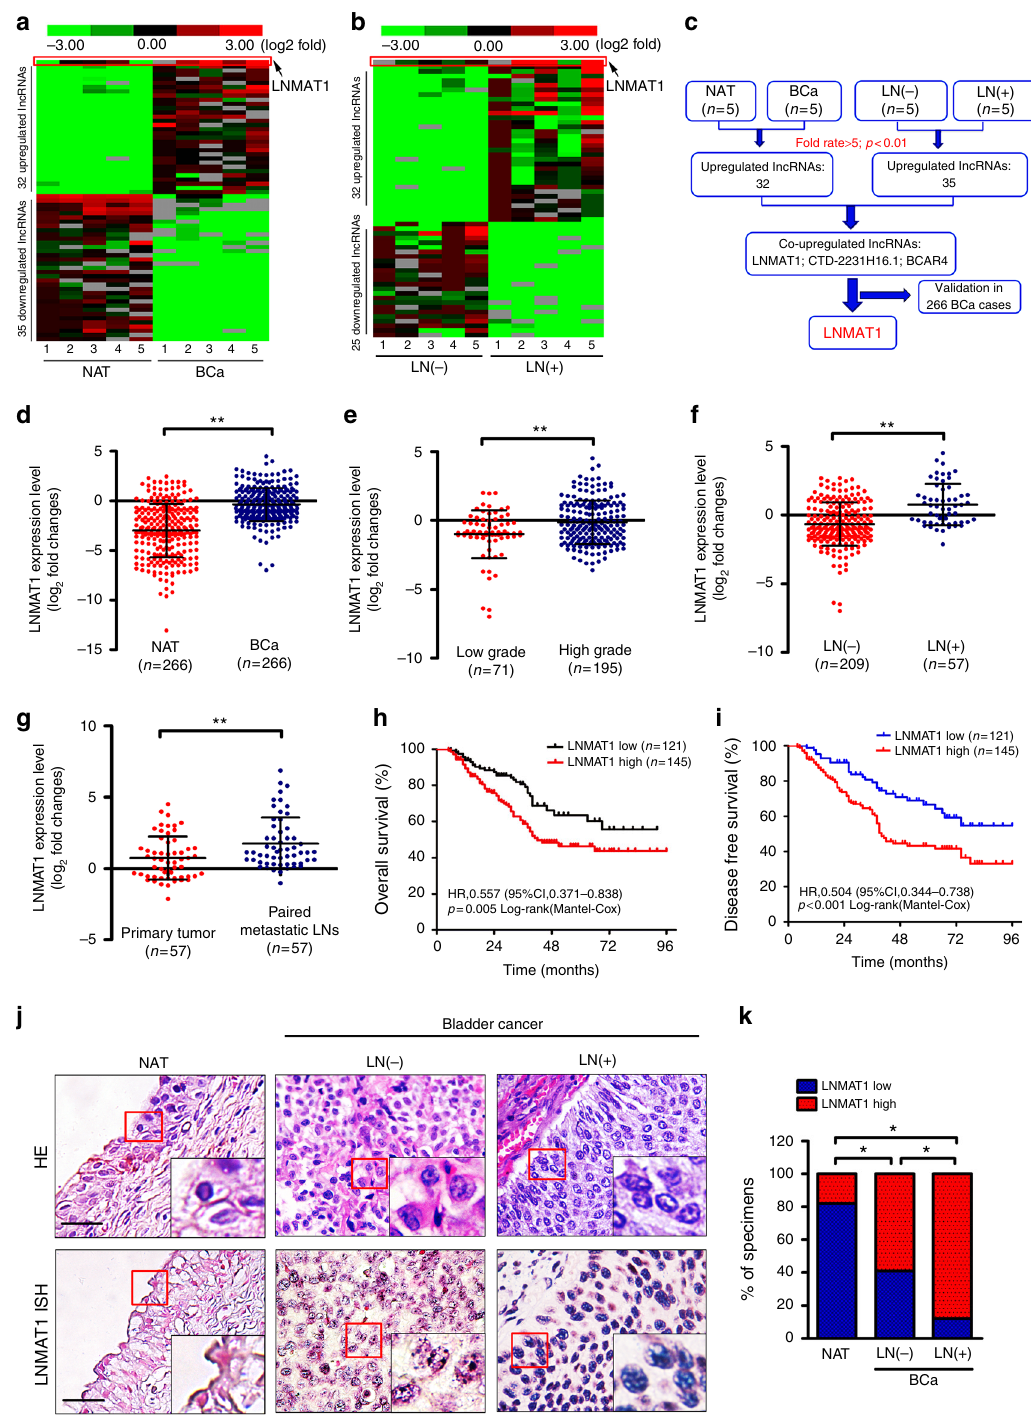
The UM-UC-3/luc and 5637/luc bladder cancer cell lines stably overexpressing LNMAT1 or a short hairpin RNA (shRNA) targeting LNMAT1 were inoculated into the footpads of nude mice ( n = 16 per group) (Fig. 2b, c). The impact of LNMAT1 on lymphatic metastasis was checked when the vector-control tumors reached the same size as the LNMAT1 tumors. Strikingly, silencing LNMAT1 notably inhibited LN metastasis. Conversely, LNMAT1 overexpression promoted the ability of the bladder cancer cells to metastasize to the LNs, as determined by